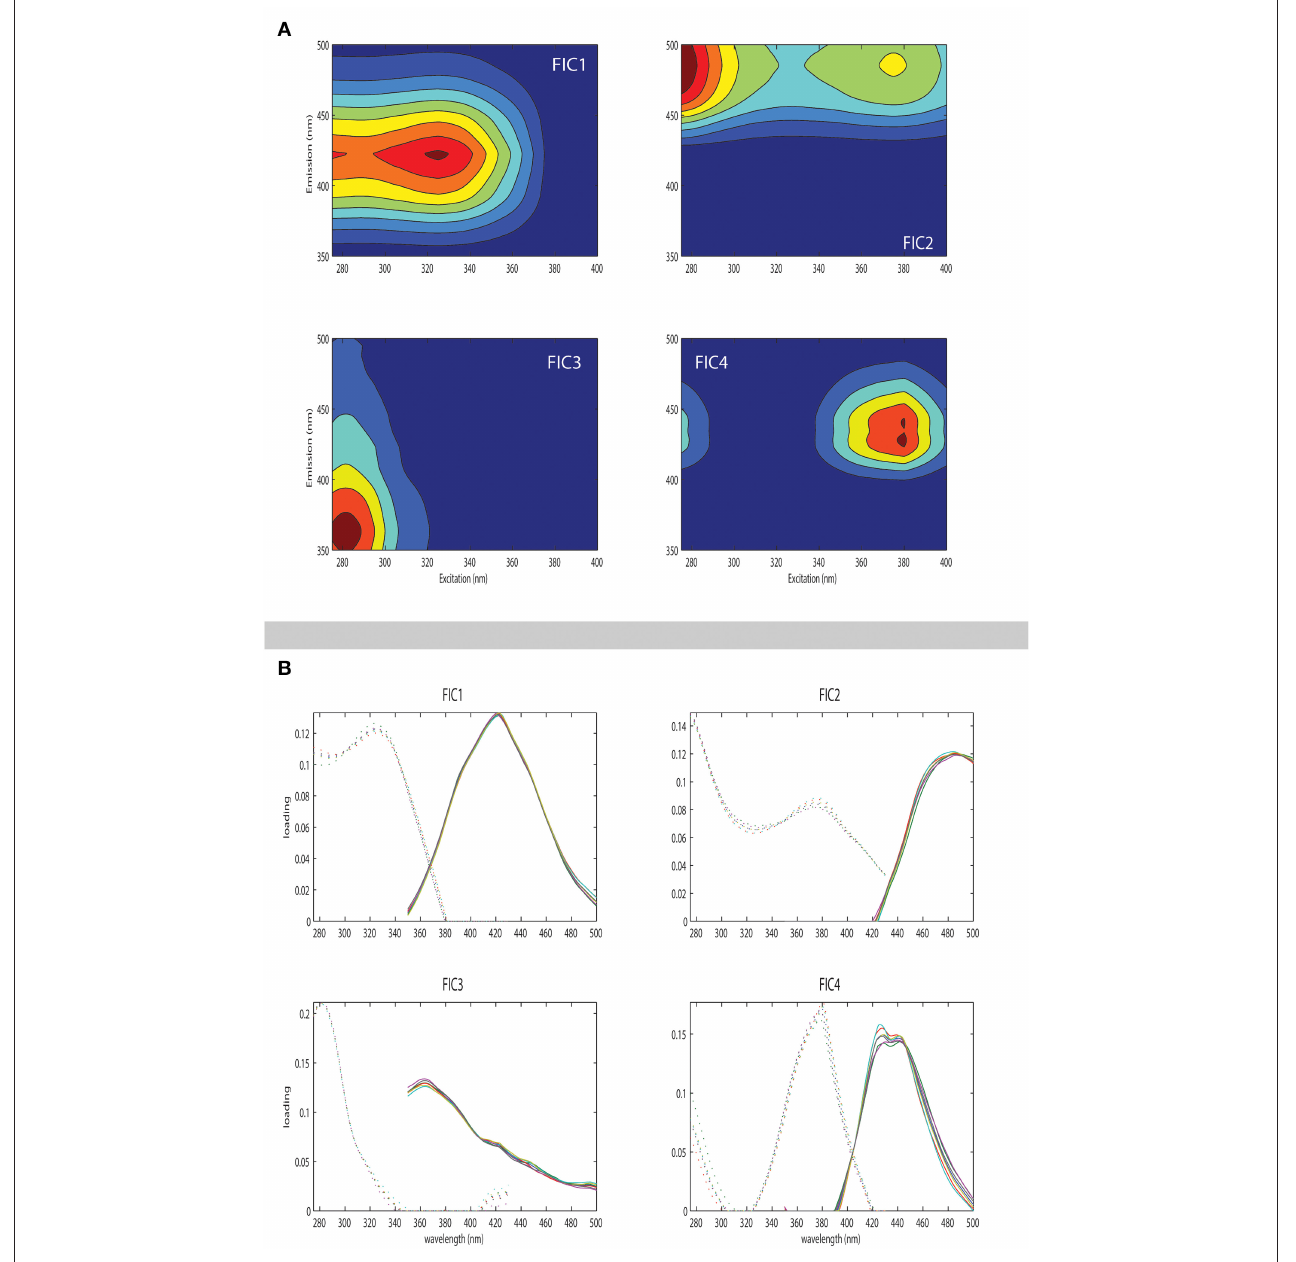
FIGURE 2 | Fluorescence signatures of the four PARAFAC components (FIC1 to FIC4) identified during the experiments are shown in panel (A). Values expressed in R.U. (B) Line plots showing split-half validations in which each component’s excitation (left) and emission (right) spectra are estimated from independent halves of the